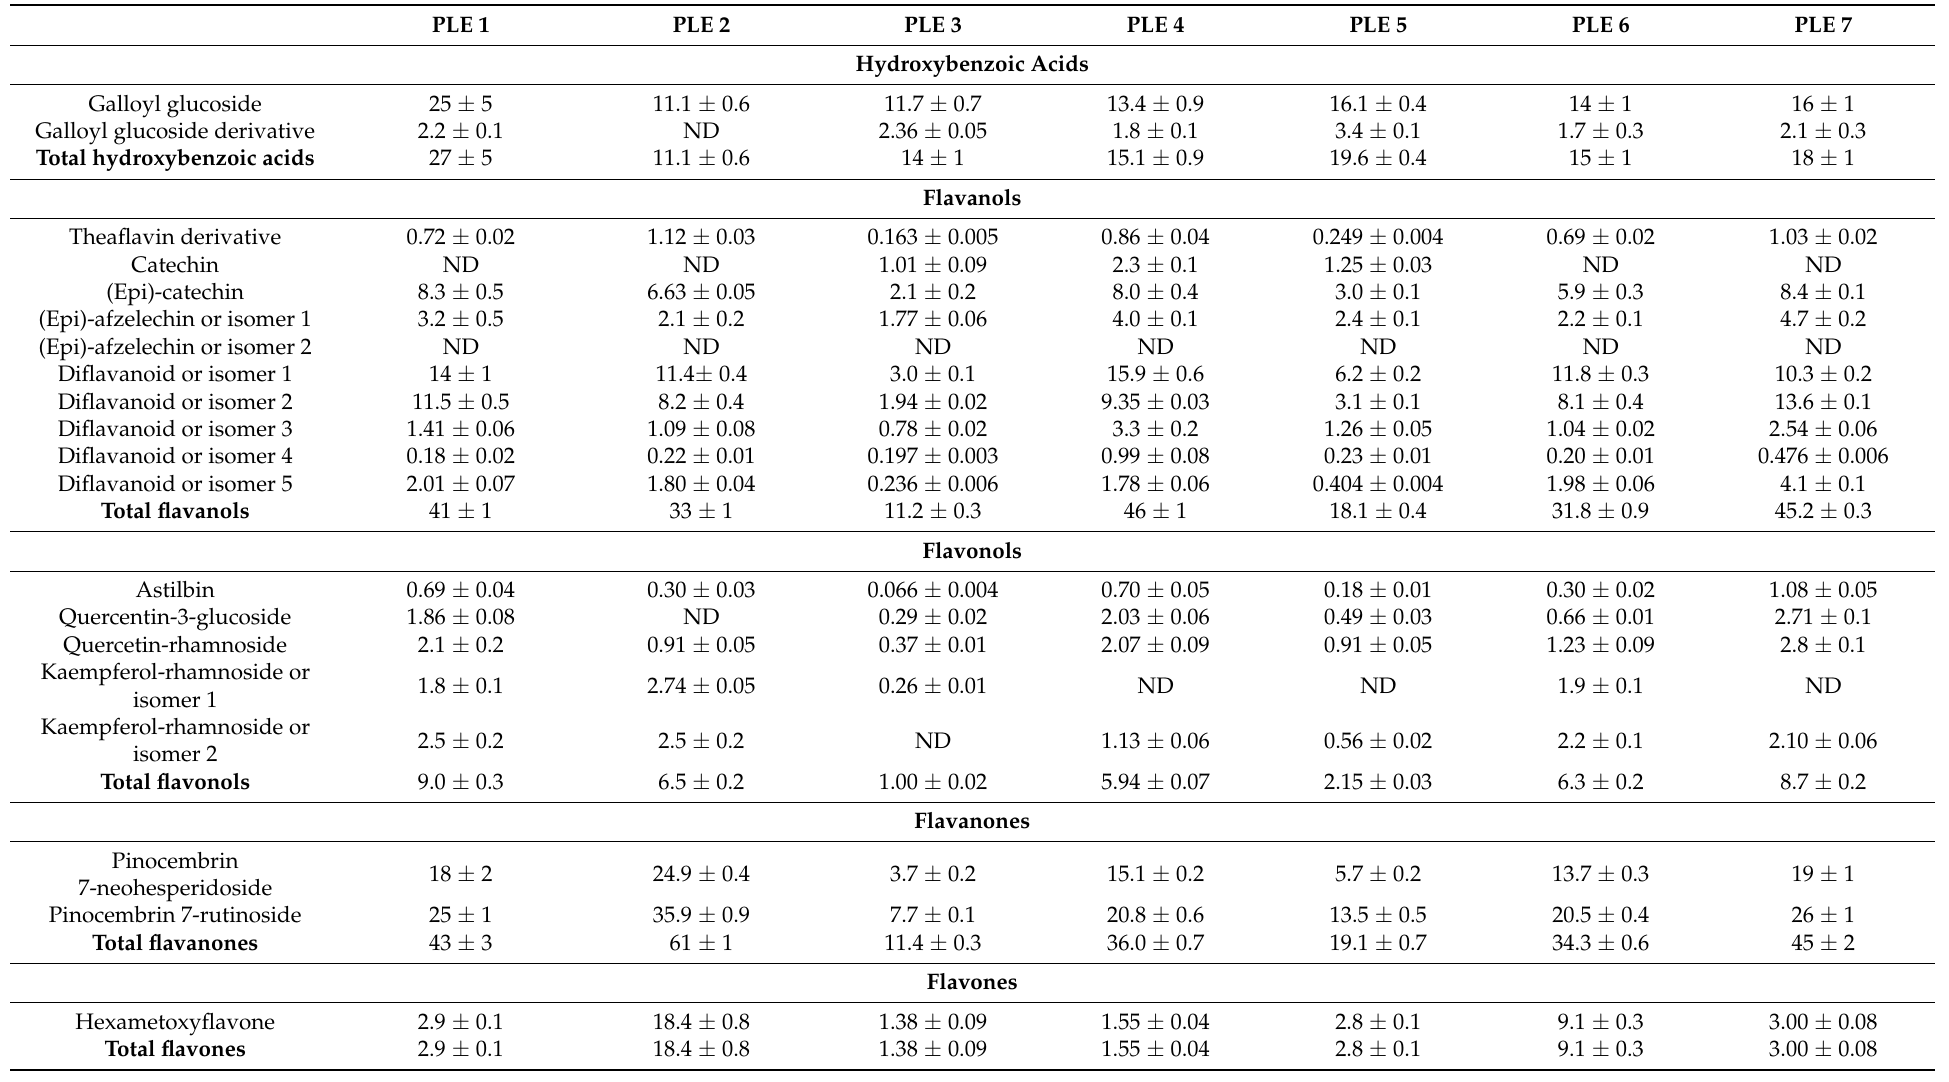
Table 5. Concentration of phenolic compounds in PLE extracts, ordered by families and expressed in mg compound/g extract (X ±